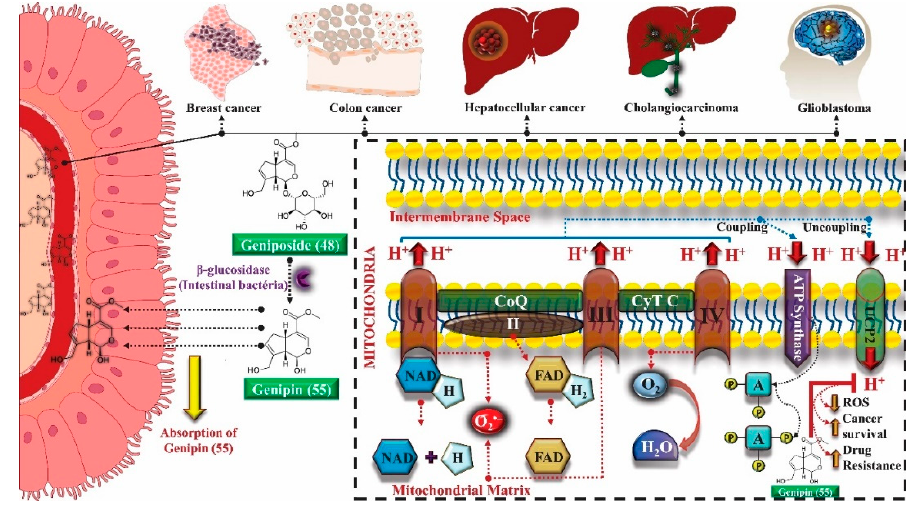
Figure 5. Effects of genipin on energy metabolism: anti-tumor property: Transport mechanisms of geniposide and genipin, which are abundantly present in extracts from plants such as Genipa americana , involve converting geniposide into genipin in the intestinal lumen through bacterial enzymes β -glucosidases. Uncoupling protein 2 (UCP2) is a genipin target in the treatment of cancer.